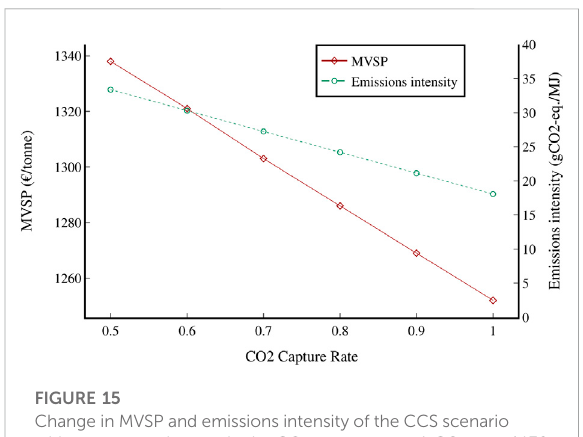
FIGURE 15 Change in MVSP and emissions intensity of the CCS scenario with respect to changes in the CO 2 capture rate. A CO 2 tax of 130 € /tonne was